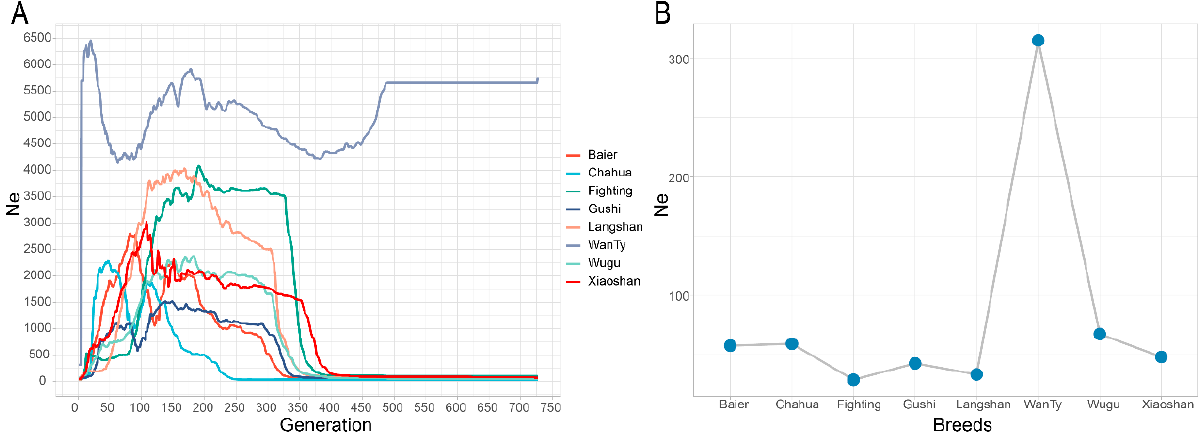
Figure 8. Historical trace of the effective population size (Ne) from the genomic data for the past 727 generations ( A ) and the effective population size at the current generation of the eight indigenous breeds ( B ).